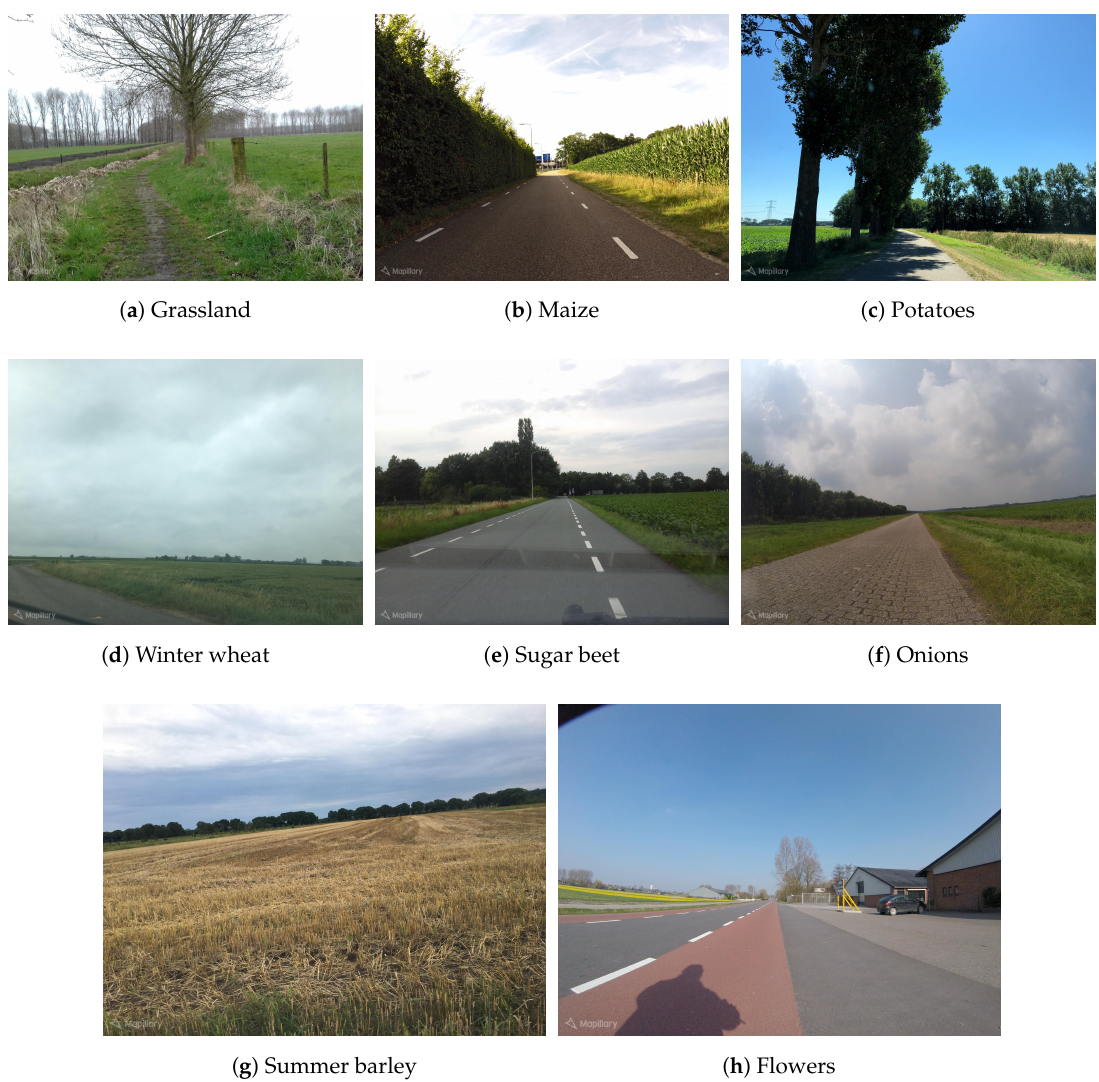
Figure 13. Street-level imagery permit to identify crop label by visual